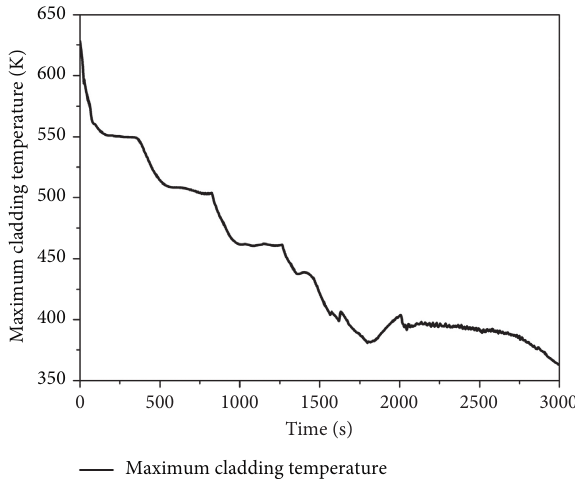
Figure 18: 2-inch CL break maximum cladding temperature.